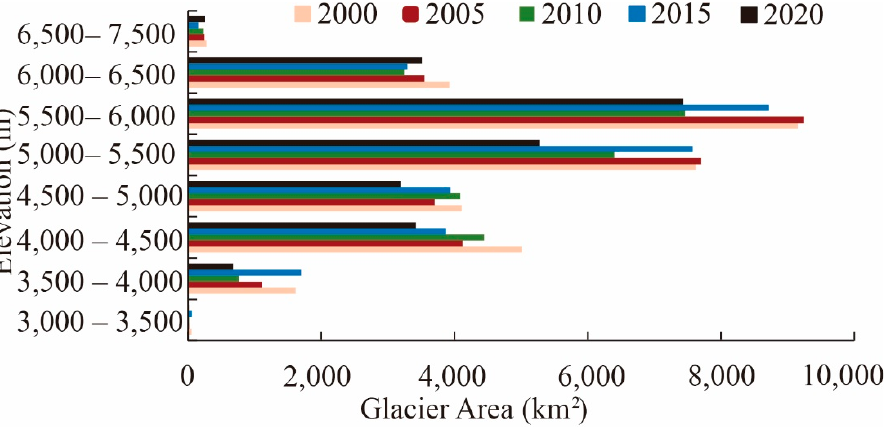
Figure 7. Distribution of glacier area vs. elevation in Tarim Basin in the year of 2000, 2005, 2010, 2015 and 2020.